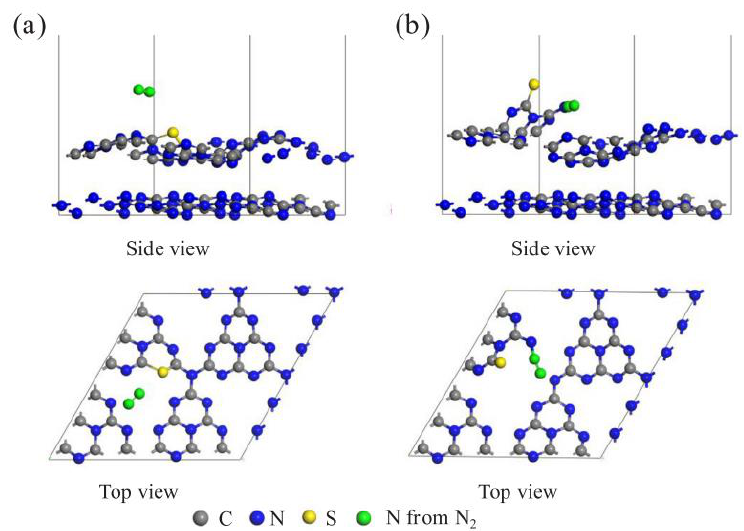
Figure 5. The optimized geometry of the optimal N 2 adsorption models on ( a ) bulk SCN and ( b ) SCNNSs − 550. Reprinted with permission from Ref. [59]. Copyright 2018, Elsevier.